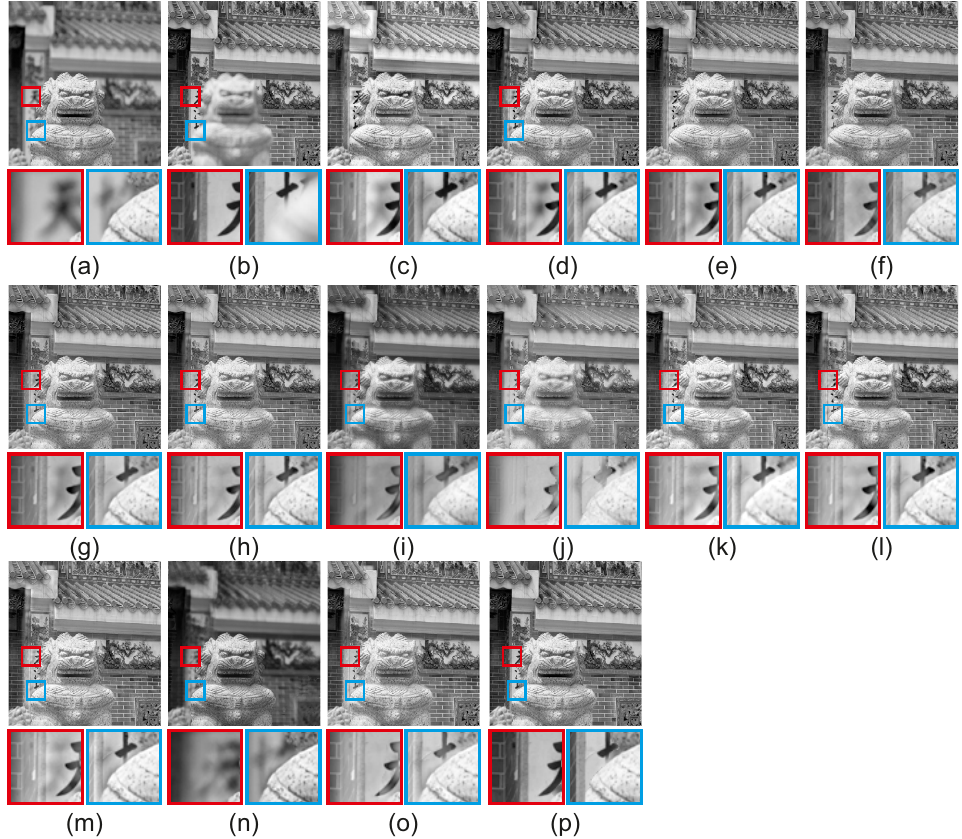
Figure 12. Fused results for the scene ‘Temple’ of the grayscale dataset [3]. ( a ) Source 1, ( b ) Source